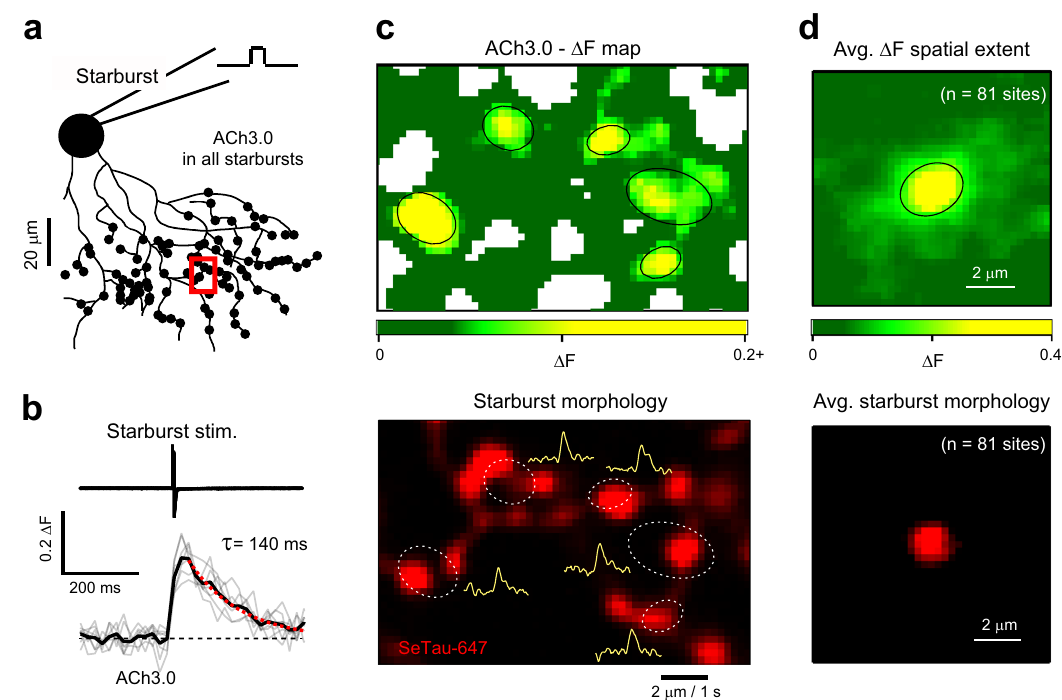
Fig. 6 Two-photon imaging of ACh activity using a genetically encoded sensor reveals that ACh release is localized to within a micron of its release site. a A genetically encoded ACh sensor (ACh3.0) was selectively expressed in many starbursts, one of which was stimulated with a patch electrode. A red indicator (SeTau-647) was included in the electrode solution, to reveal the starburst ’ s morphology. In total, data was collected from 12 starbursts across 8 retinas. b The time course of changes in ACh3.0 sensor fl uorescence ( Δ F; see Eq. 2) in the boxed region shown in ( a ), upon depolarizing the starburst (top trace; Starburst stim.). The gray traces show individual trials while the black trace indicates the average over 7 trials. The red dotted line represents an exponential fi t to the response decay (decay constant ( τ ) = 140 ms). c A high-resolution spatial map of the peak ACh3.0 responses in the boxed region shown in ( a ) (top; average over 7 trials). The white space indicates regions without ACh3.0 expression. The black contours indicate the 1 standard deviation level of a 2D Gaussian fi t of the ACh3.0 responses. The bottom image shows the morphology of the stimulated starburst mapped on to the ACh3.0 response sites (dashed white contours). The yellow traces indicate the response timecourse ( fi ltered) at each site. One such window was imaged from each starburst independently. d The average (avg.) spatial pro fi le of the ACh3.0 responses (top) and the starburst morphology (bottom) for 81 sites measured in 12 starbursts (from 8 retinas). This indicated that the ACh3.0 responses were localized to within a micron of the starburst varicosities. Source data are provided as a Source Data fi le for Fig.